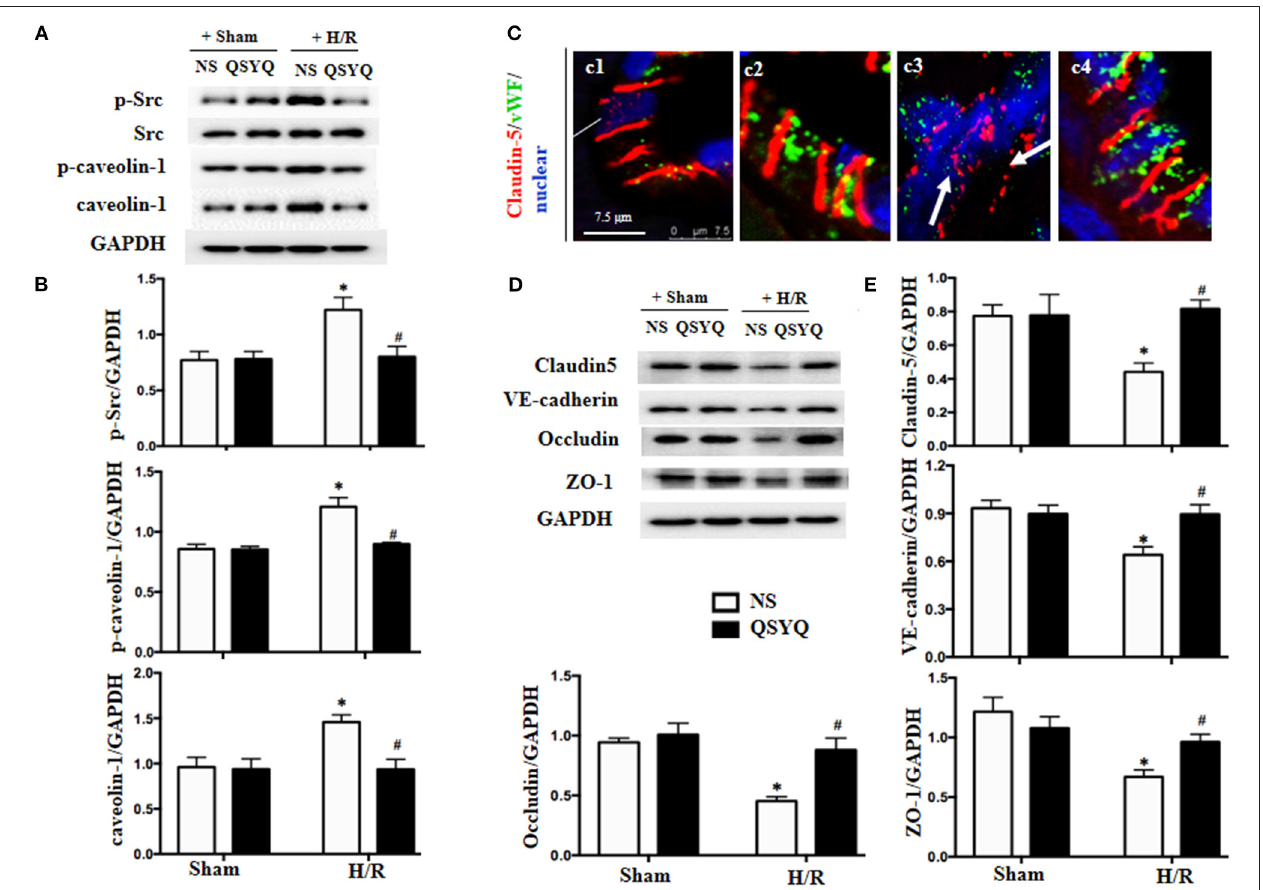
FIGURE 3 | Effect of QSYQ pretreatment on intercellular junction proteins and Src/caveolin-1 in HCMECs after H/R. (A) Representative western blot bands of Src, p-Src, caveolin-1, and p-caveolin-1 in various groups of HCMECs. GAPDH was used as a loading control. (B) Relative densitometric values of p-Src, caveolin-1, and p-caveolin-1 corrected for GAPDH. Data are expressed as means ± SEM ( n = 6). * p < 0.05 vs. NS + control group, # p < 0.05 vs. NS + H/R group. Statistical analysis was performed using two-way ANOVA followed by Bonferroni for multiple comparisons. (C) Representative immunofluorescence confocal images of claudin-5 in rat heart vessels. Arrows: discontinuous distribution of claudin-5. c1: NS + Sham group; c2: QSYQ + Sham group; c3: NS + I/R group; c4: QSYQ + I/R group. Claudin-5 (red) localized between the endothelial cells with marker vWF (green). Bar = 7.5 µ m. (D,E) Representative western blot bands (D) and relative densitometric values (E) of claudin-5, ZO-1, occludin, and VE-cadherin in HCMECs in different groups. GAPDH was used as a loading control. Data are expressed as means ± SEM ( n = 6). * p < 0.05 vs. NS + control group, # p < 0.05 vs. NS + H/R group. Statistical analysis was performed using two-way ANOVA followed by Bonferroni for multiple